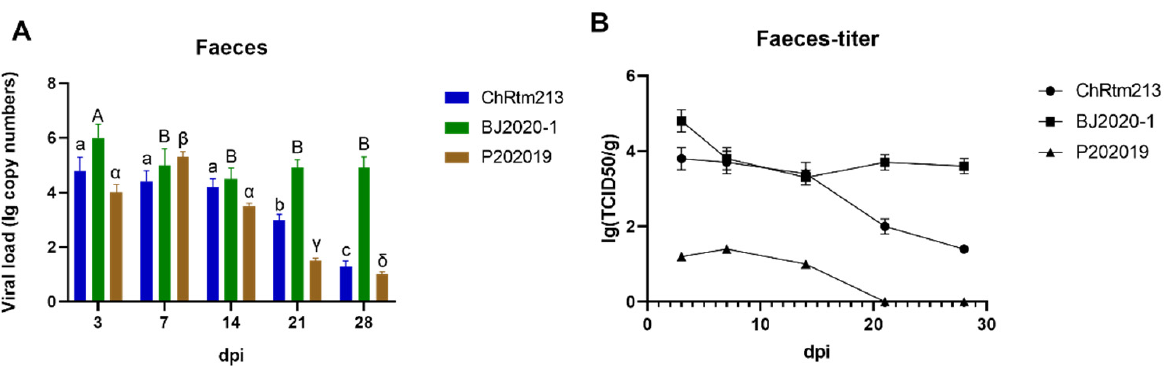
Figure 9. IPNV virus loads in feces were sampled on 3, 7, 14, 21, and 28 dpi. ( A ) Replication kinetics of IPNV-infected rainbow trout. Samples were obtained in triplicate. Total RNA was extracted and analyzed by qPCR. Error bars represent the SD from triplicate within an experiment. Different letters of the same class indicated the statistical significance, p < 0.05. a, b, c indicated that the viral load of IPNV-ChRtm213 was significantly different at different sampling time points, p < 0.05. A, B indicated that the viral load of IPNV-BJ2020-1 was significantly different at different sampling time points, p < 0.05. α , β , γ , δ indicated that the viral load of IPNV-P202019 was significantly different at different sampling time points, p < 0.05. ( B ) The detection of viral titers in feces of IPNV-infected rainbow trout.